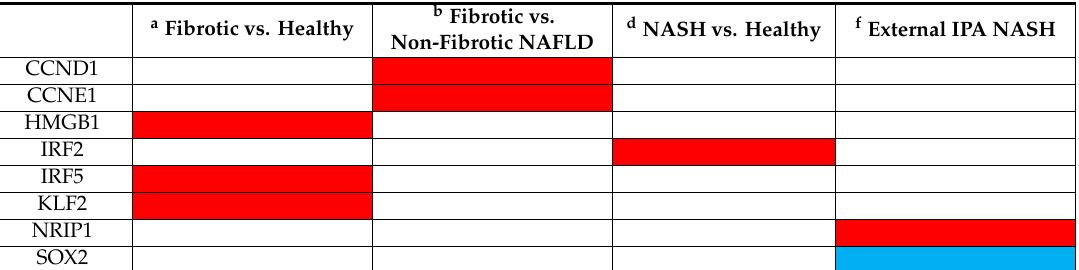
Table 5. IPA prediction of upstream mechanistic networks that are unique to each human NASH cohort. b Fibrotic vs. a Fibrotic vs. Healthy d NASH vs.